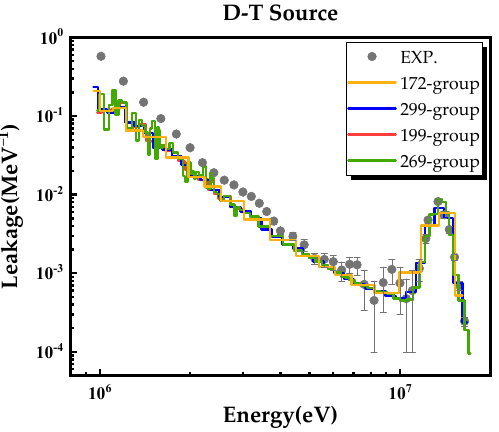
Figure 8. DT source neutron leakage spectra of iron sphere with outer radius 38.1 cm and thickness 30.45 cm.